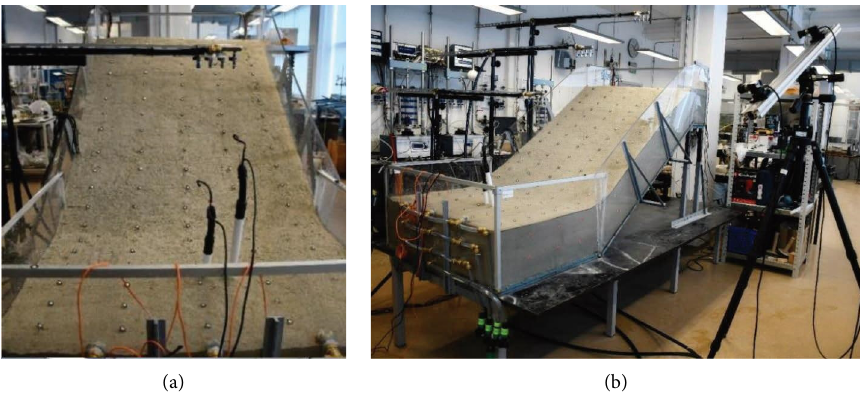
Figure 1: Photo of the small-scale landslide model at 35 ° : (a) front view; (b) side view.